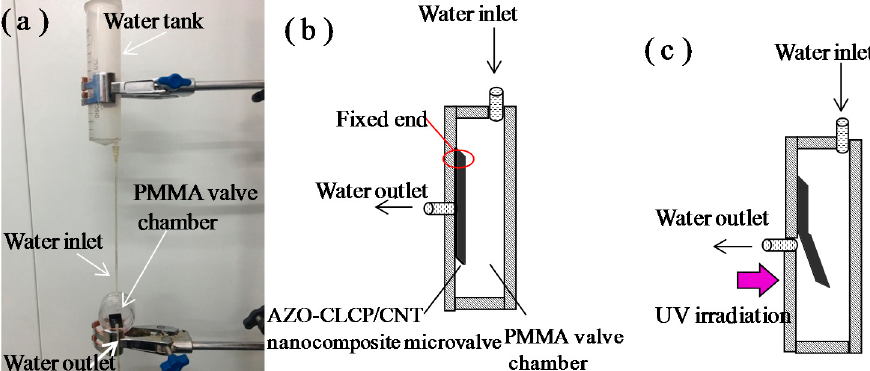
Figure 6. ( a ) A Photograph of experimental setup of the conceptual device of microfluidic system. A CF20 with the size of 12 mm × 6 mm × 20 µm was used as the microvalve actuator; ( b ) A Scheme of the PMMA valve chamber with the AZO-CLCP/CNT nanocomposite microvalve actuator set in it without the UV irradiation; ( c ) A Schematic illustration of the switching on process of the microvalve under irradiation of UV light.